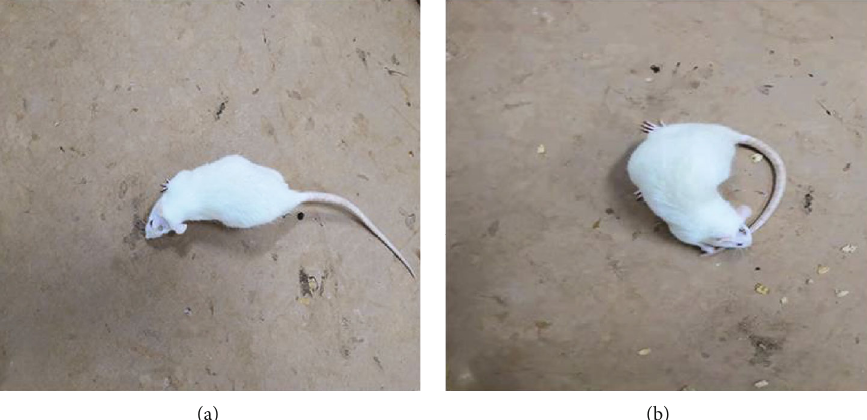
Figure 5: Parkinson ’ s disease model validation. Apomorphine was intraperitoneally injected, and the rat was placed in a square box. After 5 – 30 minutes, the rat can be observed to rotate to the contralateral side of the modeled side > 7 laps/min: (a) the unsuccessful rat model; (b) the successful model